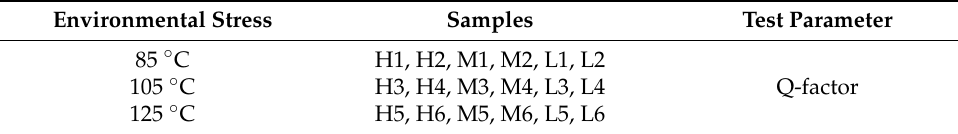
Table 2. Test conditions and grouping.